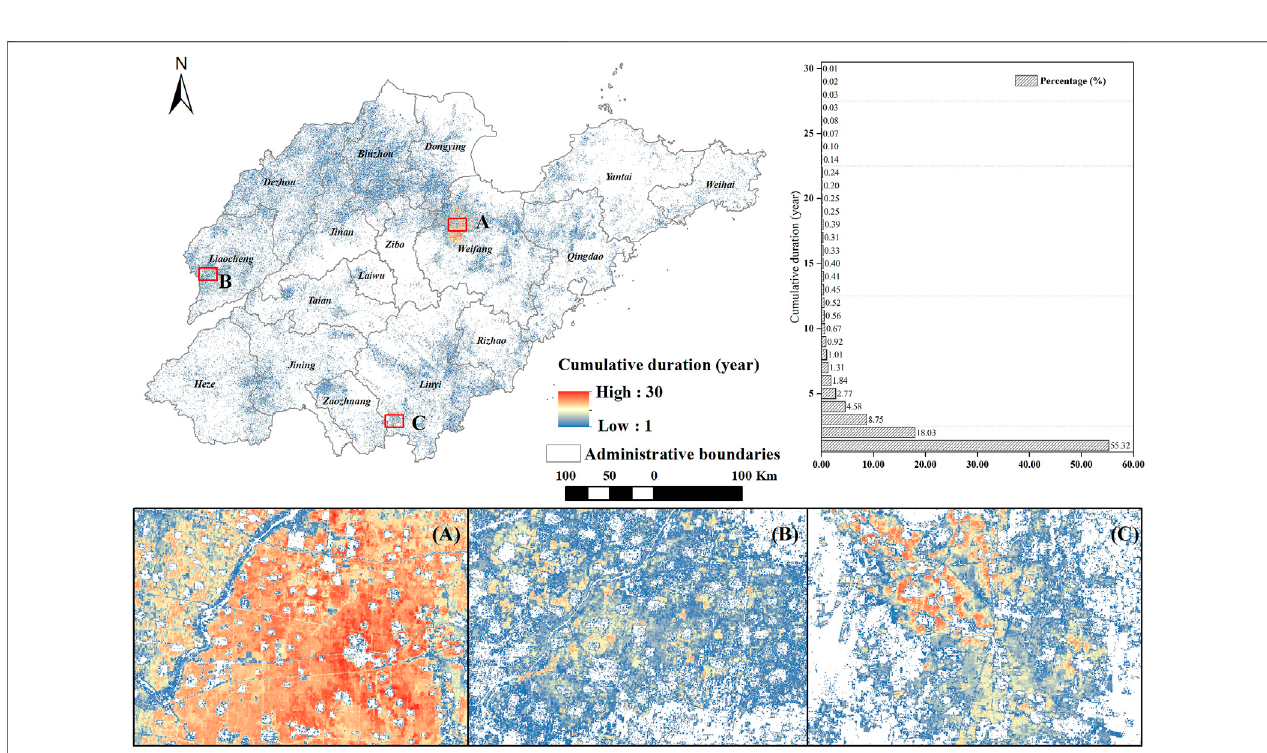
FIGURE 4 | The cumulative duration patterns of GCL: (A) enlarge area A, (B) enlarge area B, and (C) enlarge area C.